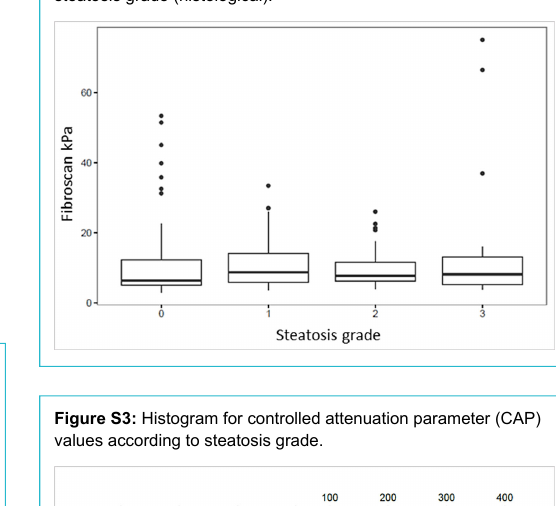
Figure S3: Histogram for controlled attenuation parameter (CAP) values according to steatosis grade.